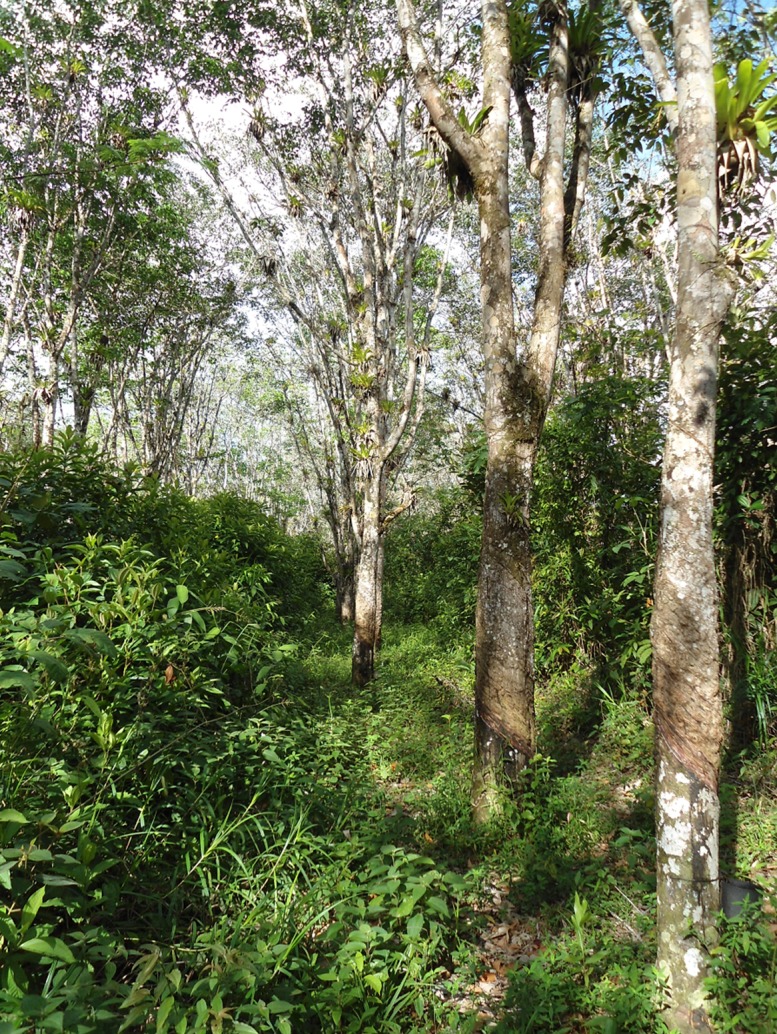
Rubber trees as tall as 15 m with medium-developed inter-rows.